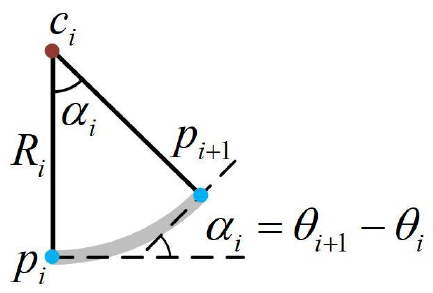
Figure 9. Arc model.